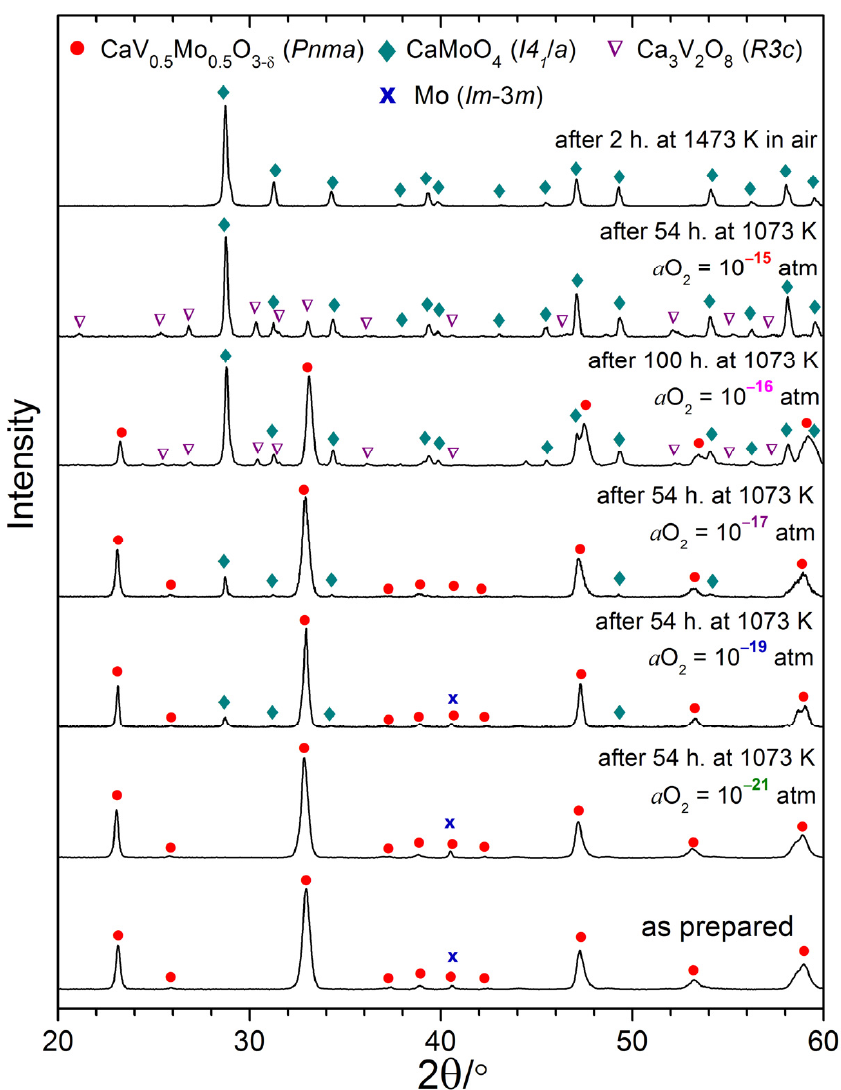
Figure 6. XRD patterns of CaV 0.5 Mo 0.5 O 3± δ samples after an exhibition at various conditions.